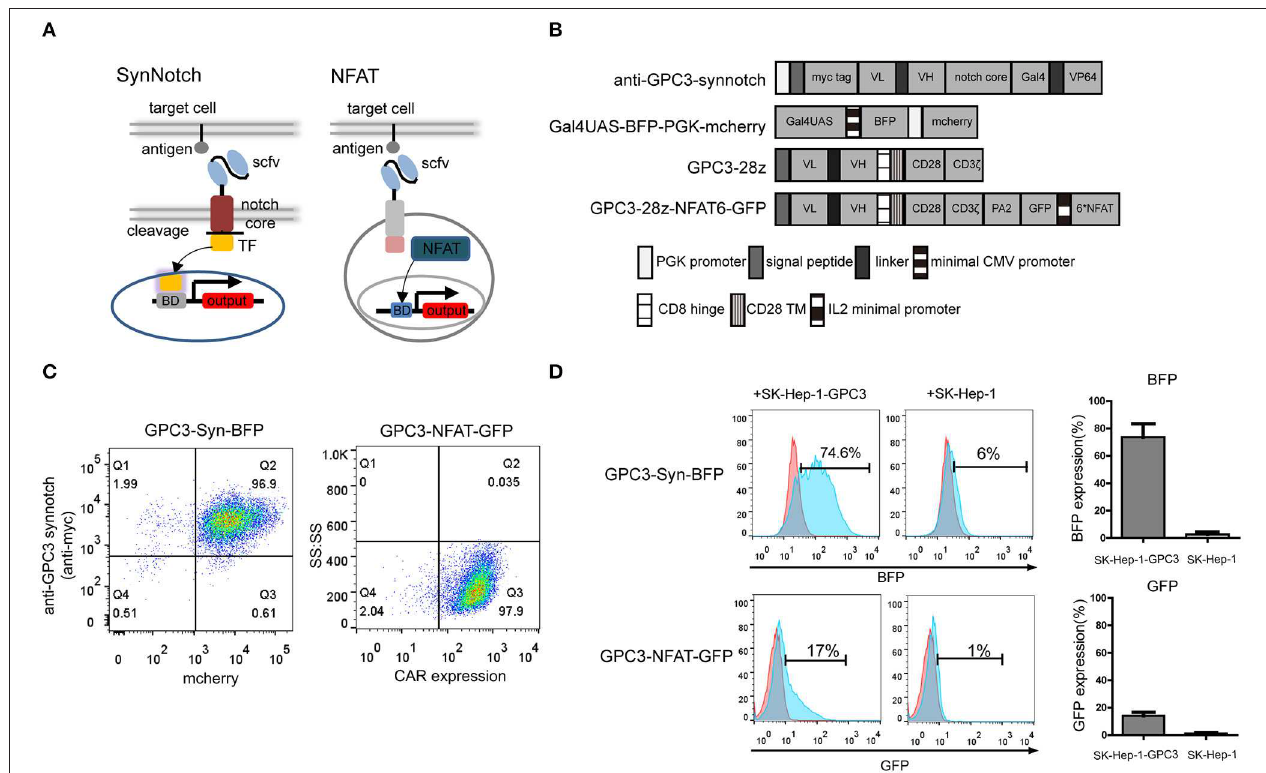
FIGURE 1 | Construction and comparison of GPC3-specific synNotch receptor and NFAT-responsive promoter in NK92 cells. (A) Schematic representation of the synNotch and NFAT regulation system and the lentiviral vectors (B) . In the anti-GPC3-synNotch vector, the anti-GPC3 scfv is linked to the Notch core and the transcription factor. The reporter Gal4UAS-BFP-PGK-mCherry vector encodes BFP under the Gal4UAS promoter. The GPC3-28Z consisted of a CD8 α signal peptide (SP), a humanized GPC3-specific signal chain antibody fragment (scfv), a CD8 α signal hinge region and CD28 transmembrane region (TM), followed by the intracellular domains of co-stimulatory CD28 and intracellular domain of CD3 ζ . The GPC3-28Z-NFAT-GFP vector expresses GFP under the transcriptional control of the inducible minimal IL2 promoter that contains 6 NFAT-binding motifs. (C) GPC3-specific synNotch and NFAT NK92 cell expression were analyzed using flow cytometry. CAR expression on the NK92 cells was detected with goat anti-human biotin-conjugated anti-Fab antibody followed by PE-conjugated streptomycin. The data shown are representative with similar results. (D) In vitro regulator efficiency of NK92 cells with two different regulator systems following activation with specific target cells. The reporter BFP and GFP fluorescence levels after co-culturing of NK92 cells with target SK-Hep-1-GPC3 or SK-Hep-1 cells for 24h. The histogram shows the expression rate of reporter genes. Each experiment was repeated at least twice with similar